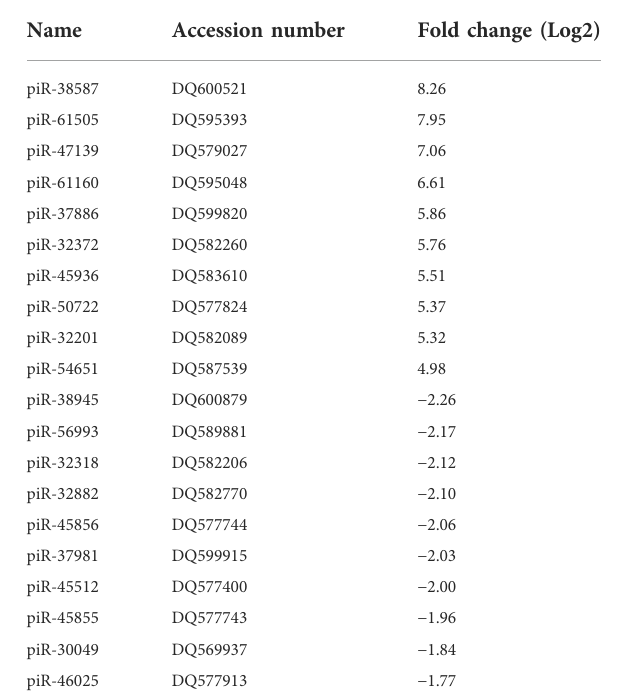
TABLE 2 Top 10 highly up- ( ≥ 4 fold) and down-regulated ( ≤ 4 fold) piRNAs by RSV 15 h p.i. ( p ≤ 0.01). DQ is the accession number of piRNA in the NCBI database.